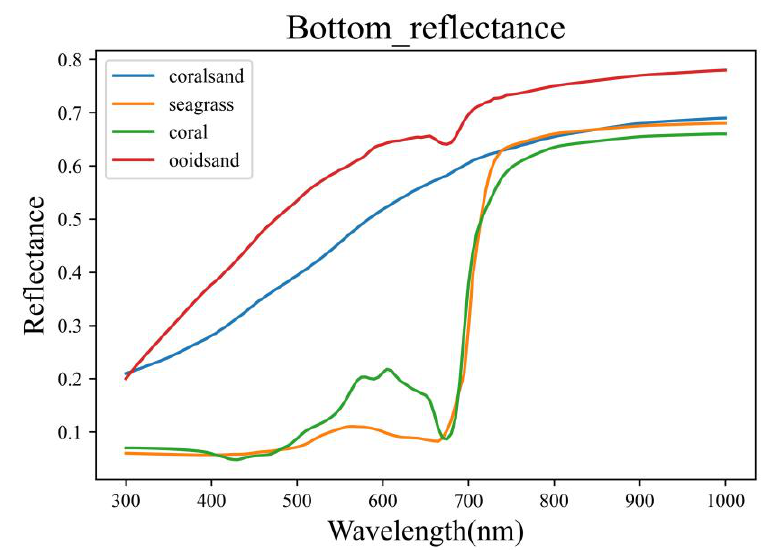
Figure 5. Bottom reflectance spectrum from Hydrolight.